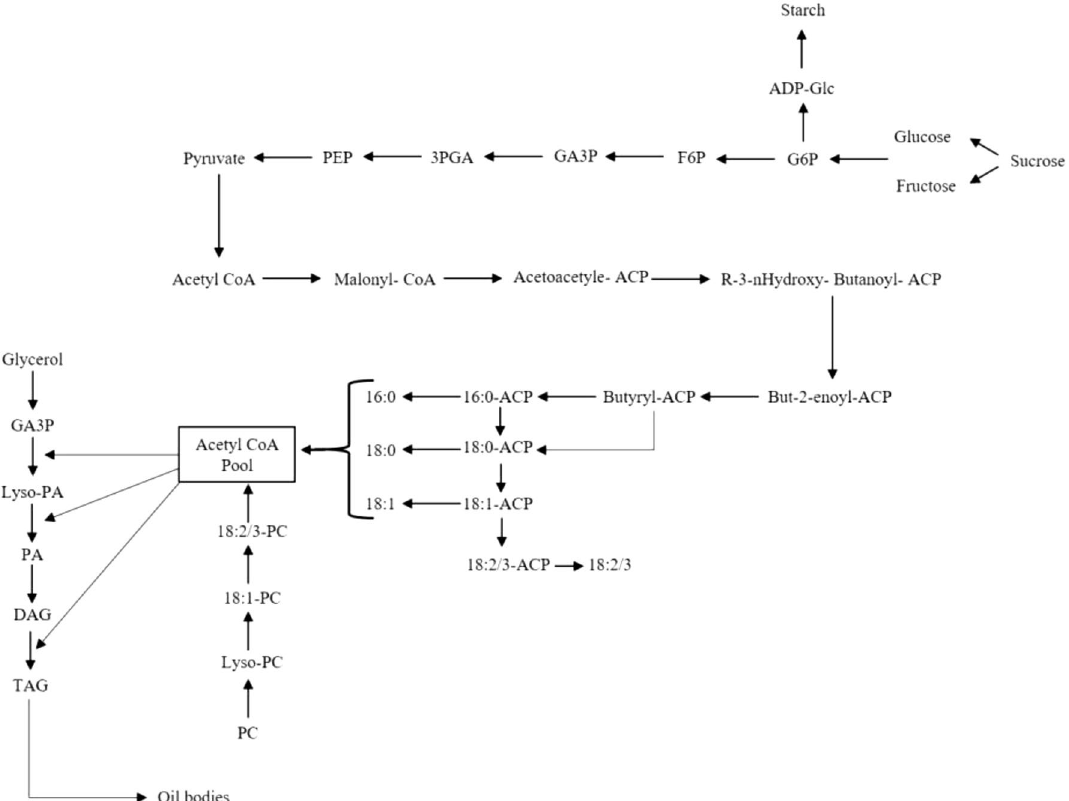
Figure 4. Integrated Carbohydrate and fatty acid biosynthesis pathways [Adapted from 59 with modifications]. G6P glucose 6-phosphate, ADP-Glc ADP-glucose, T6P trehalose 6- phosphate, F6P fructose 6-phosphate, GA3P glyceraldehyde 3-phosphate, 3PGA 3-phosphoglyceric acid, PEP phosphoenolpyruvate, CoA coenzyme A, ACP acyl-carrier protein, Lyso-PC lysophosphatidylcholine, Lyso-PA lysophosphatidic acid, DAG diacylglycerol, TAG triacylglycerol. This figure is created by Microsoft PowerPoint software (Version 2016; Microsoft Corporation. Retrieved from https:// www. micro soft. com/ en- us/ micro soft- 365/ power